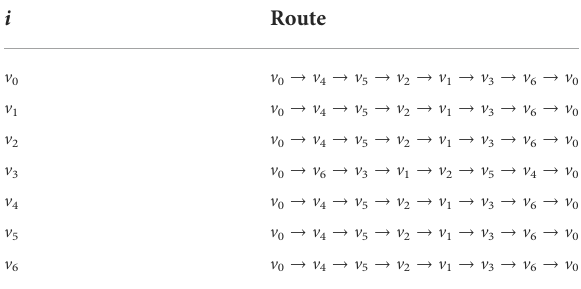
TABLE 6 Nodes i that double the time weights w ( v i , v j , τ ), w ( v j , v i , τ )( 8 j ∈ V , 8 τ ∈ T ) and the shortest route. i Route